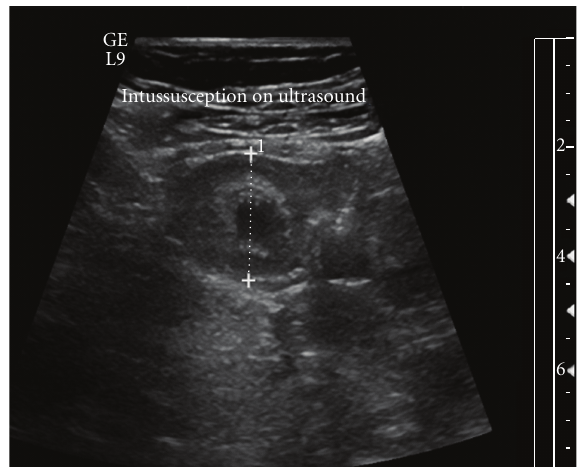
Figure 1: Transabdominal ultrasound with mass in right lower quadrant.